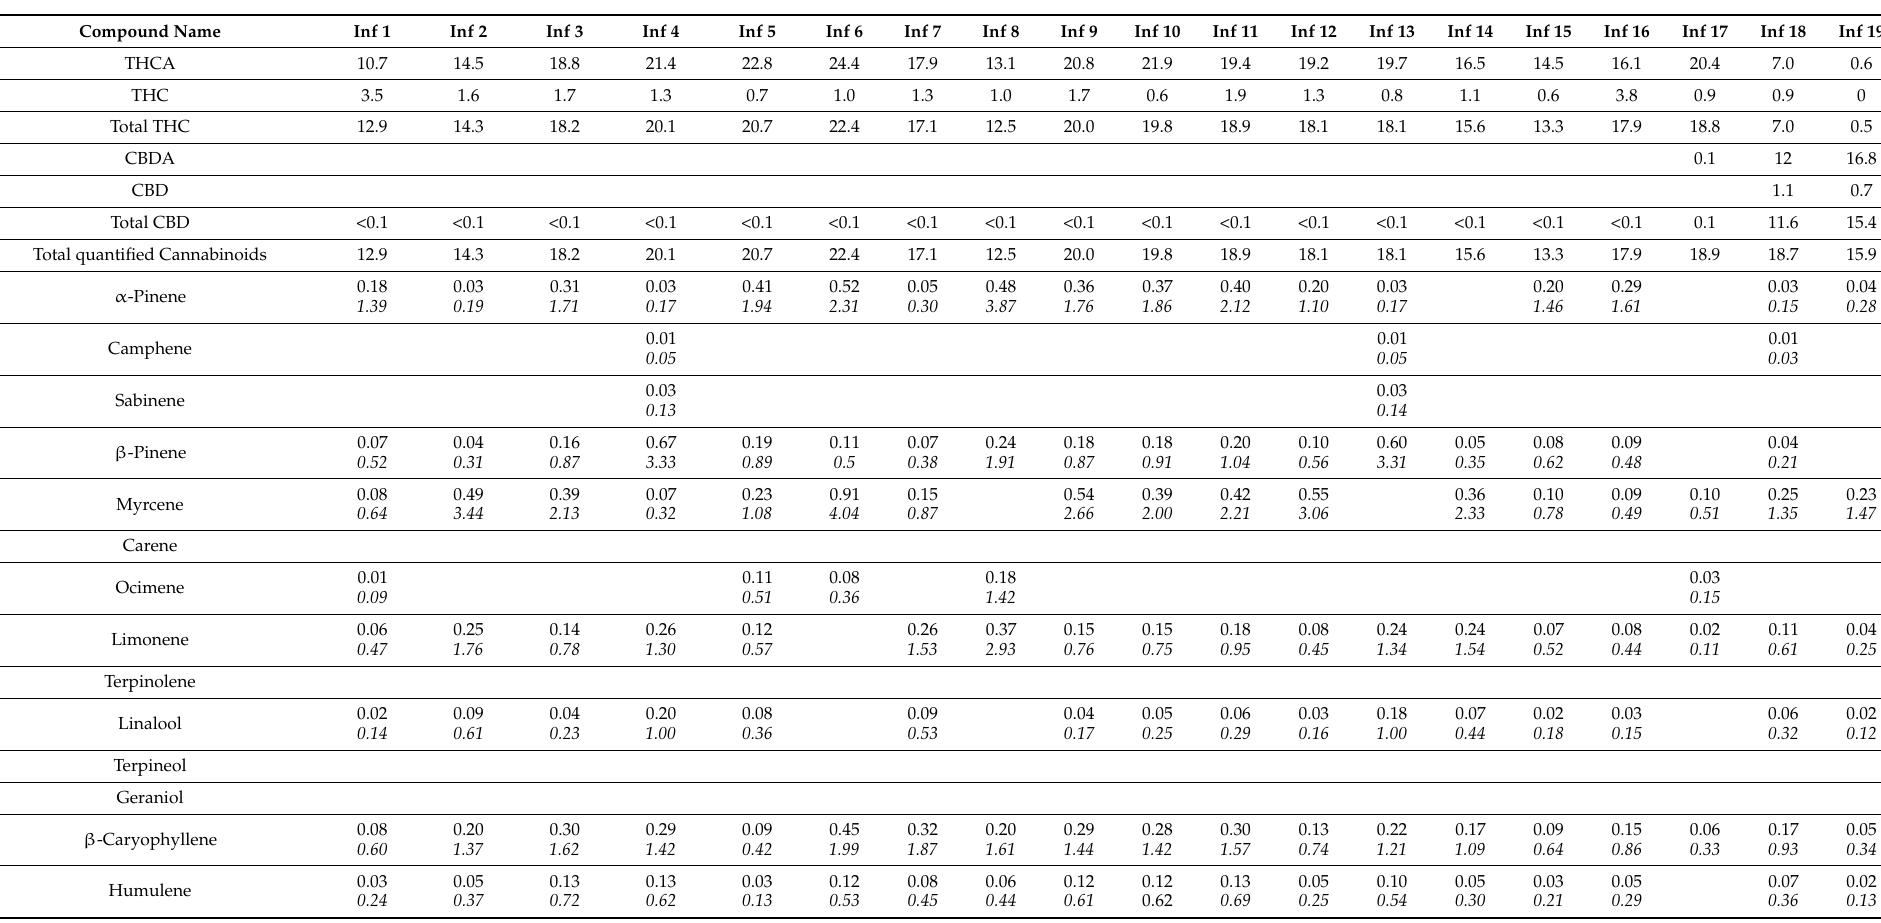
Table 2. Cannabinoid and terpene compositions in commercial medical cannabis inflorescences in Israel. Data is presented as absolute percentage 1 and in the form of milligrams of each terpene per 100 mg total cannabinoid content ( in italic